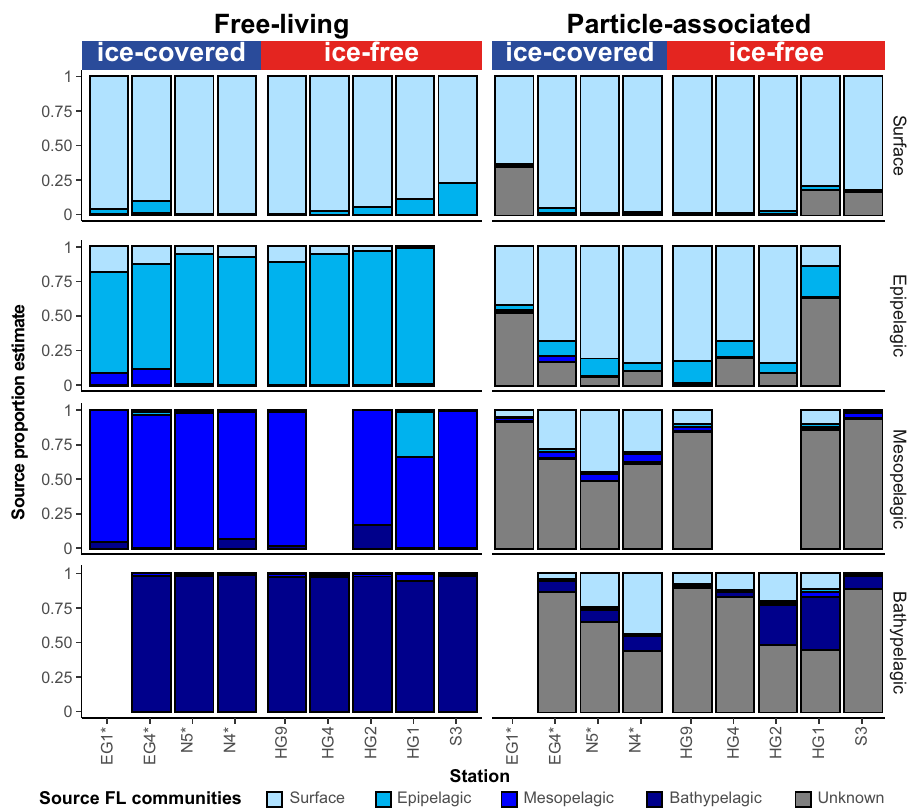
Fig. 4 Proportion estimates of the source water masses for microbial communities in different water layers. Each bar plot represents the fraction of the microbial community linked to its most probable water mass source, estimated using ‘ SourceTracker ’ . The source estimates for each free-living (FL) community was conducted estimated using leave-one-out approach (i.e., based on all other FL communities; see methods), and the sources of the particle- associated (PA) communities were estimated based on the FL communities. The ice-covered stations are marked with an